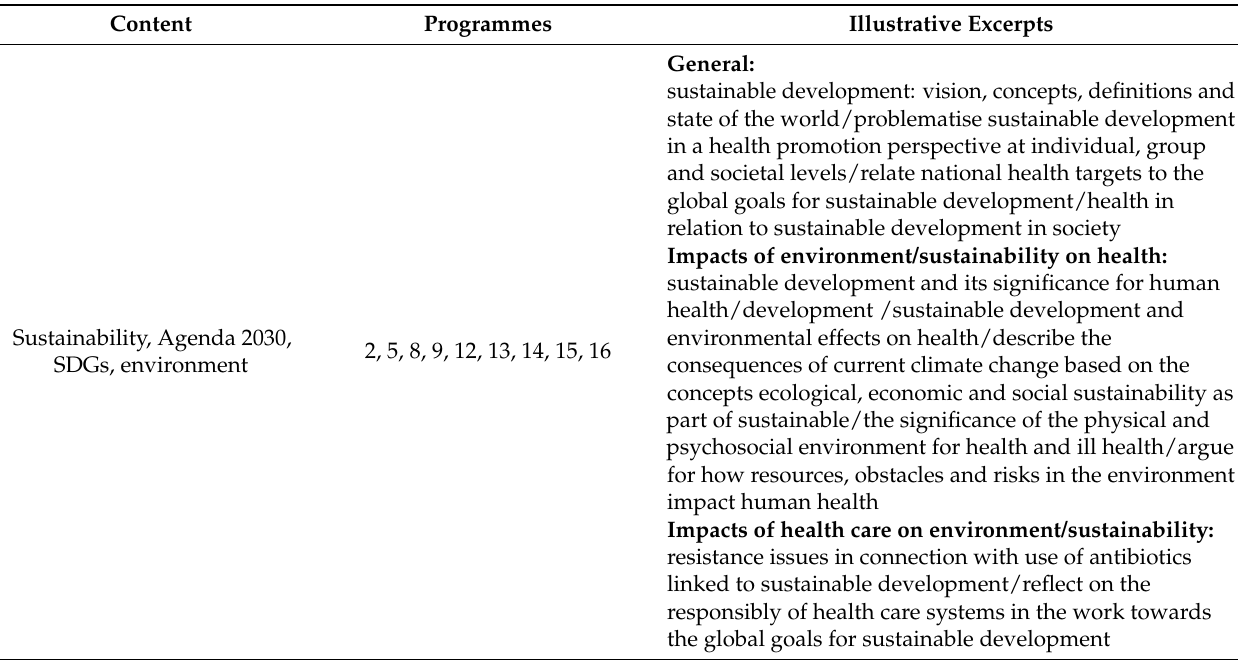
Table 8. Overview of sustainability and environmental content in the syllabi.